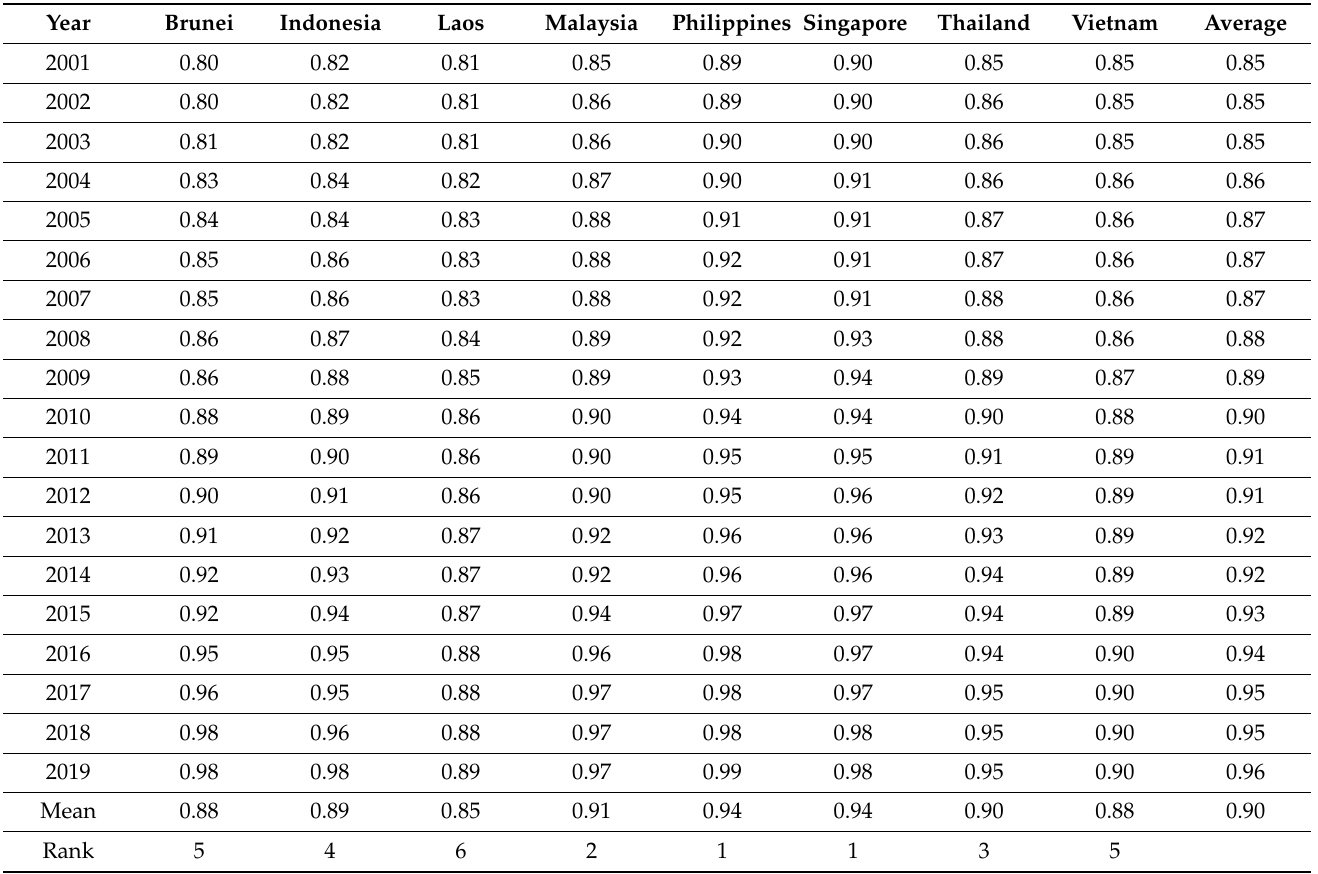
Table 5. The trend of energy efficiency in ASEAN